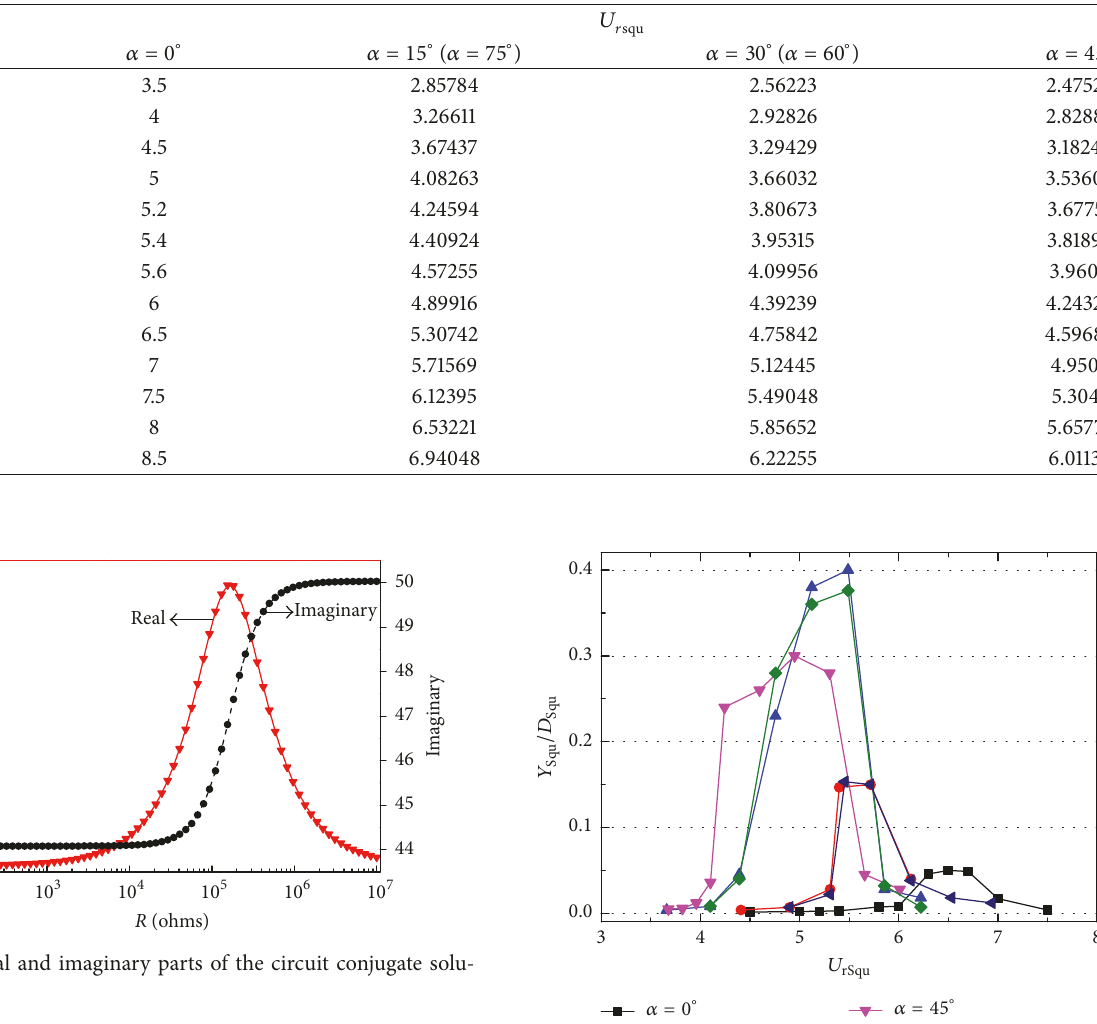
𝑈 = 6.5 , as shown in 𝑟 squ